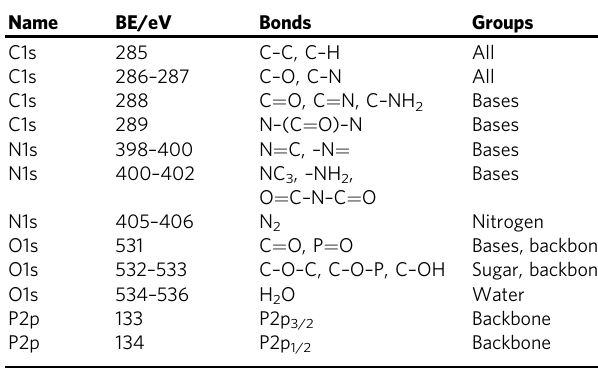
Table 1 Peak assignment and binding